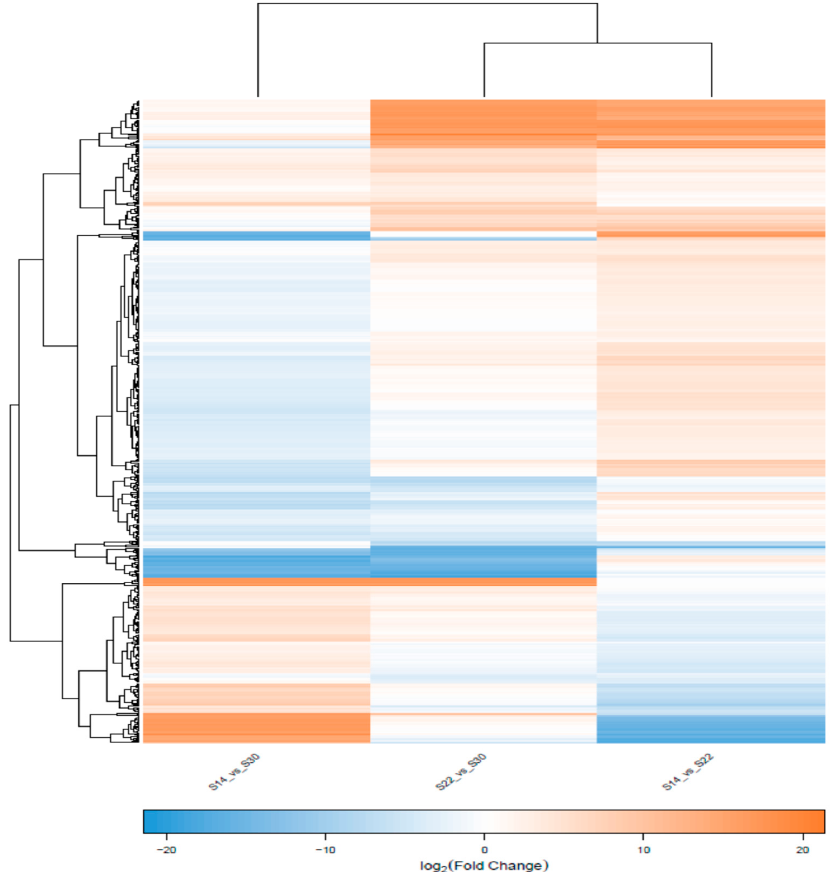
Figure 3. Hierarchical clustering of DEGs in the three groups of Anadara kagoshimensis with different salinity treatments. The intensity of the color from green to red indicates the magnitude of differential expression. Orange and blue indicate up- and down-regulation, respectively.